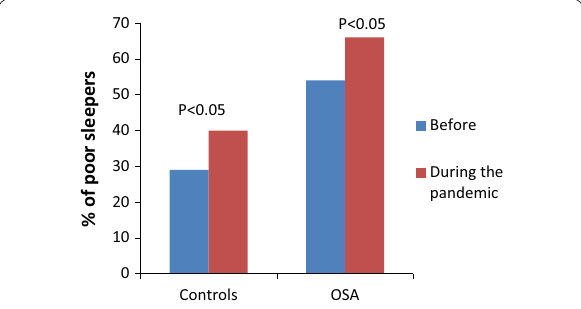
Fig. 1 Prevalence rate of poor sleepers (PSQI > 5) among OSA and controls before and during the first wave of the COVID-19 pandemic